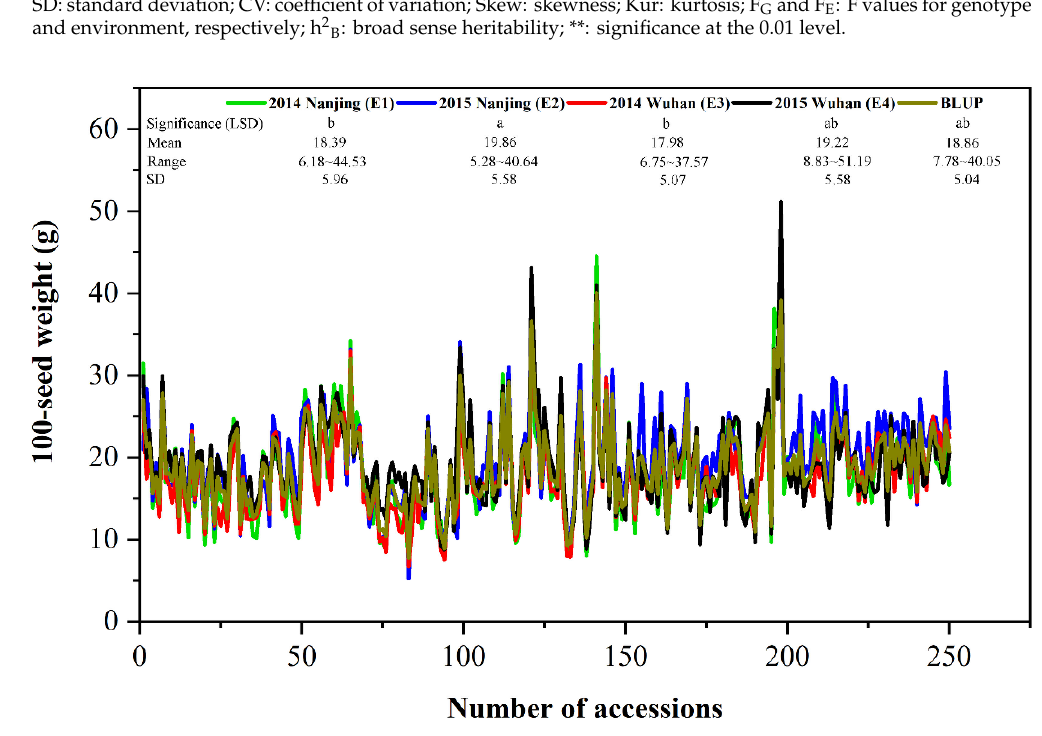
Figure 1. Phenotypic distributions of 100-seed weight in 250 soybean accessions in four environments and BLUP. SD: standard deviation. The significant differences of 100-seed weight among four environments/BLUP are tested by the LSD method at the 0.05 level of significance.